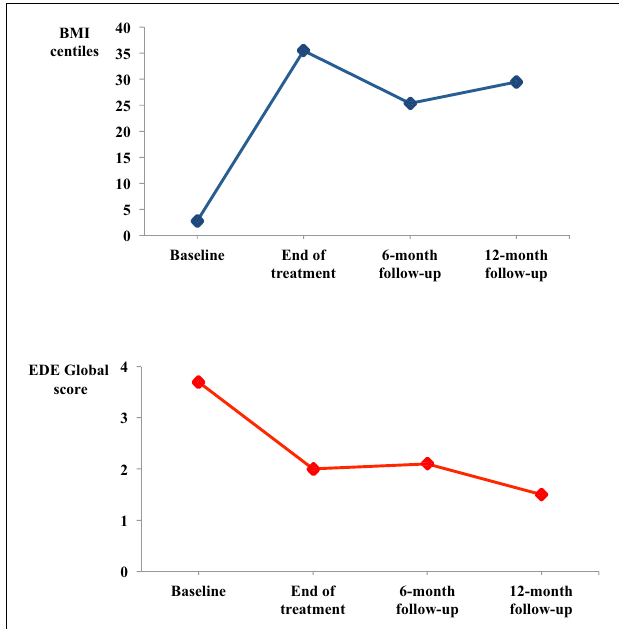
FIGURE 1 | Mean body mass index (BMI) centile and eating disorder psychopathology (global EDE) over treatment and 12-month of follow-up among those patients who completed inpatient CBT-E ( n = 26)